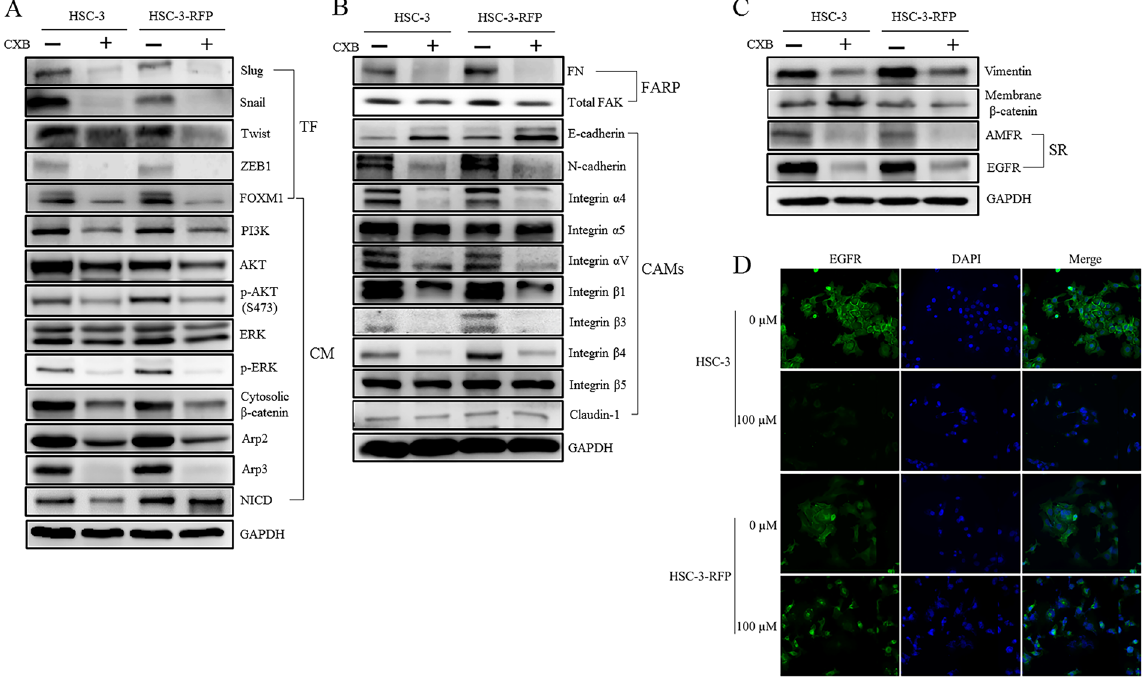
Figure 2. The molecular mechanism of CXB effect on OSCC proliferation, EMT programs and cancer cell motility. The expression level of selected markers of ( A ) nuclear transcriptional factors (TF) and cytoplasmic mediators (CM); ( B ) focal adhesion related proteins (FARP) and cell adhesion molecules (CAMs); ( C ) intermediate filament protein, membrane binding protein and surface receptors (SR) were determined between CXB-untreated and treated HSC-3 and HSC-3-RFP cells in an immunoblotting assay (also refer Supplementary Fig. 3); and ( D ) the inhibitory effect of CXB on EGFR (green fluorescence) was further validated by the ICC-IF